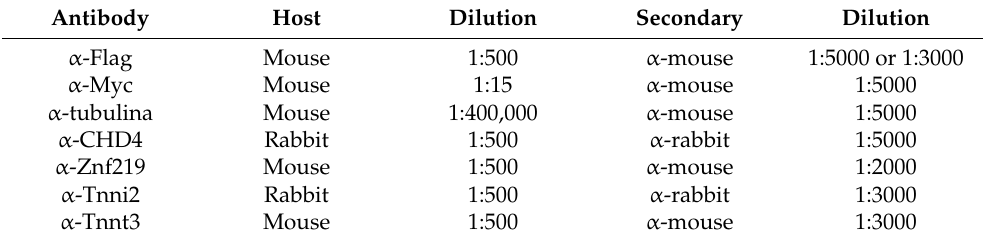
Table 2. Primary and secondary antibodies used and their respective